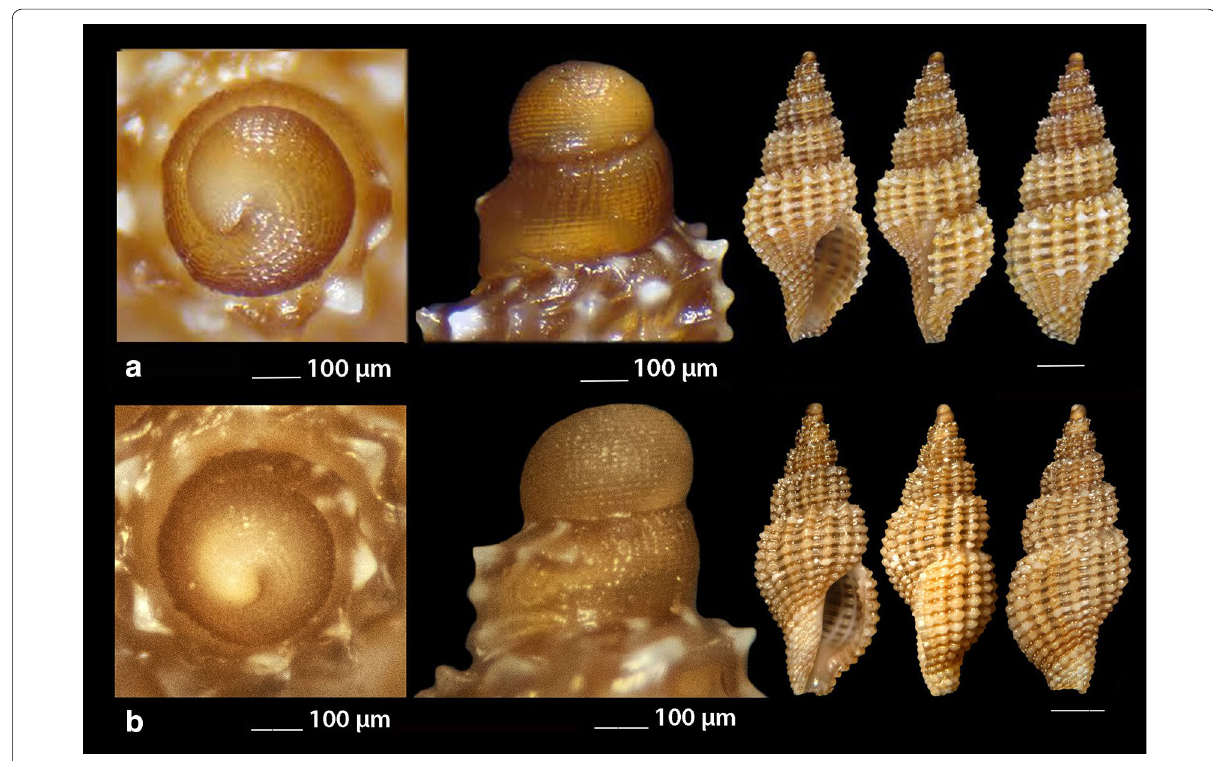
Fig. 17 a , b Raphitoma spadiana . Bar